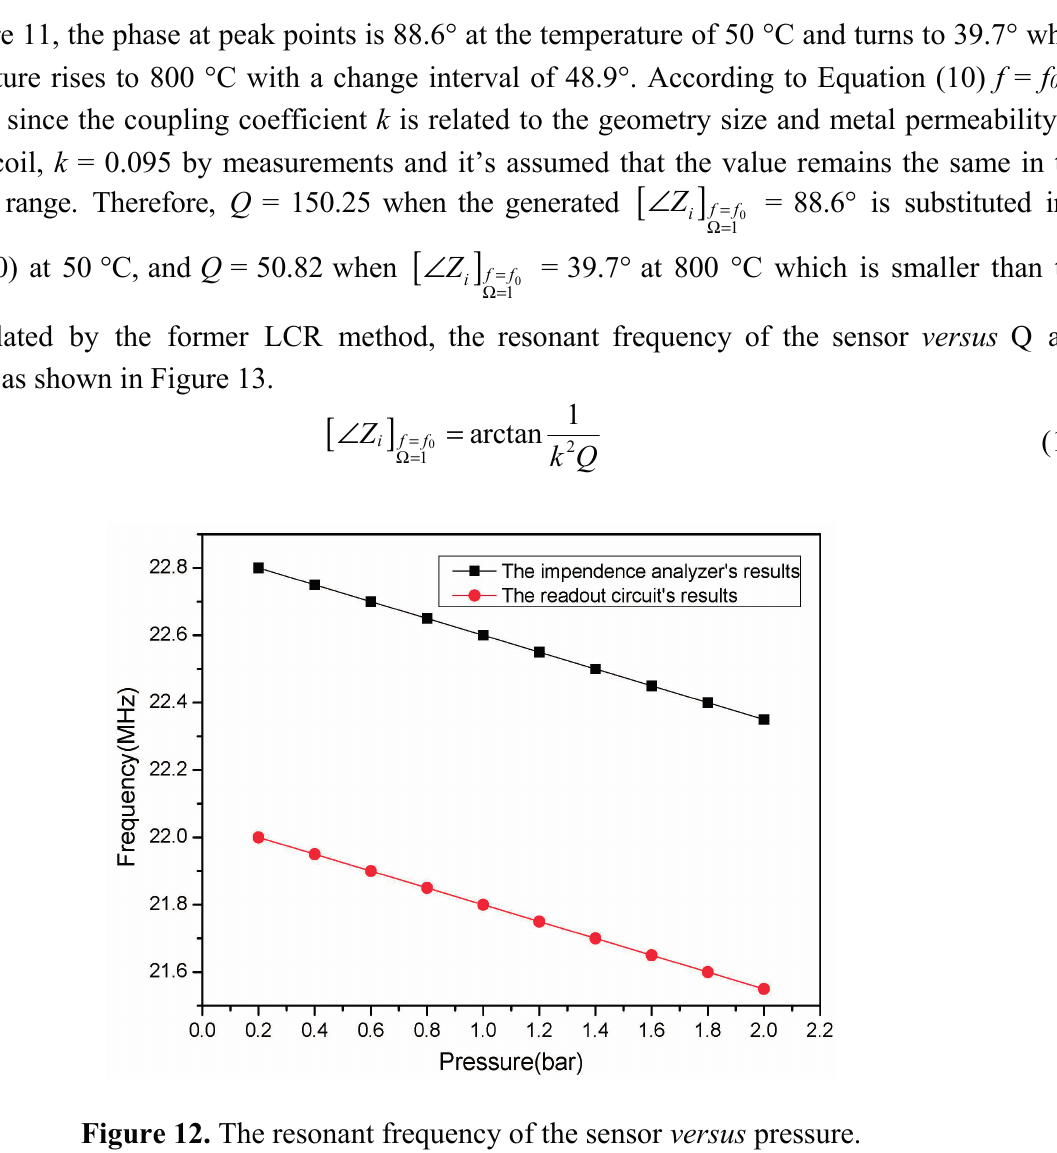
Figure 12. The resonant frequency of the sensor versus pressure.